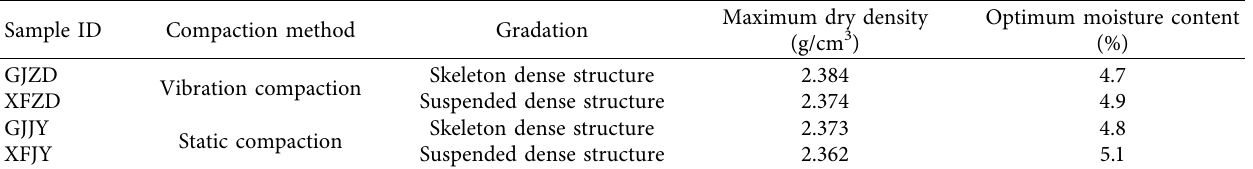
Table 2: Sample properties.